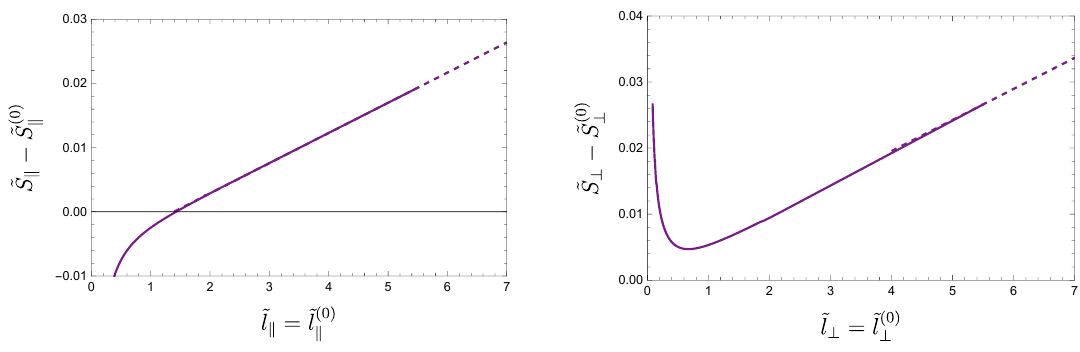
Figure 6 . Differences in the finite contributions to the entanglement entropy between the flavored and unflavored theories. We have set (cid:15) = 0 . 01 and ˜ δ = 0 . 1 . The slope of the dashed lines are fixed by the flavor contribution to the thermal entropy